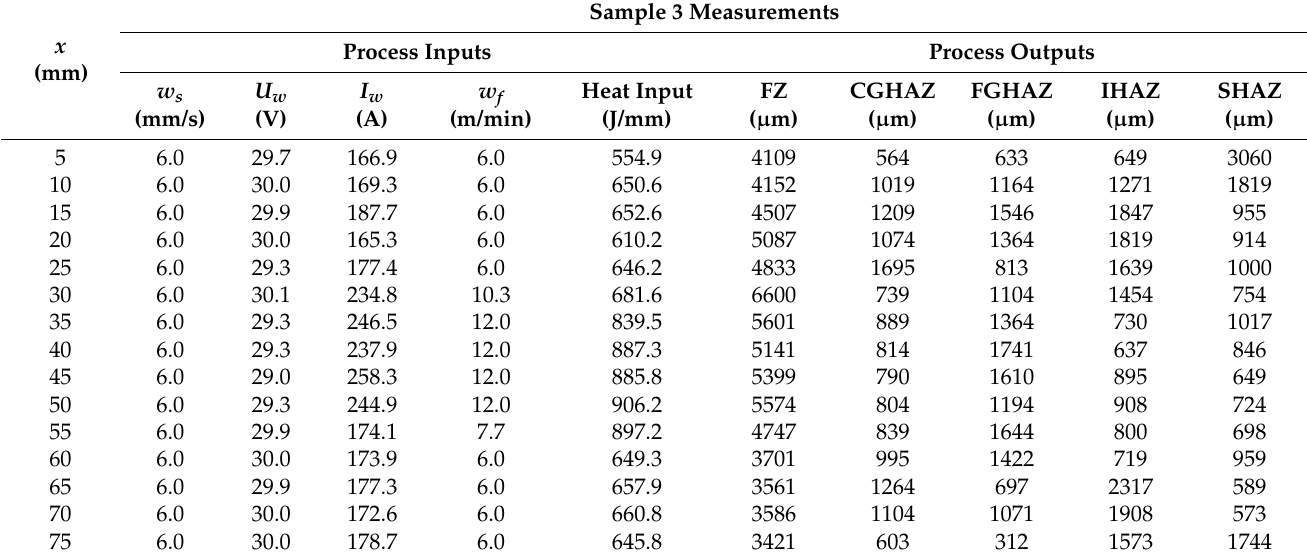
Table 6. Measurements corresponding to sample